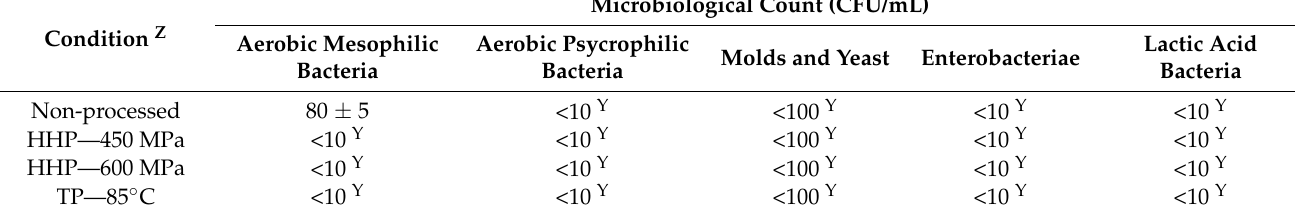
Table 3. Microbiological quality of non-processed, pressurized, and pasteurized citrus-maqui beverages at zero time of